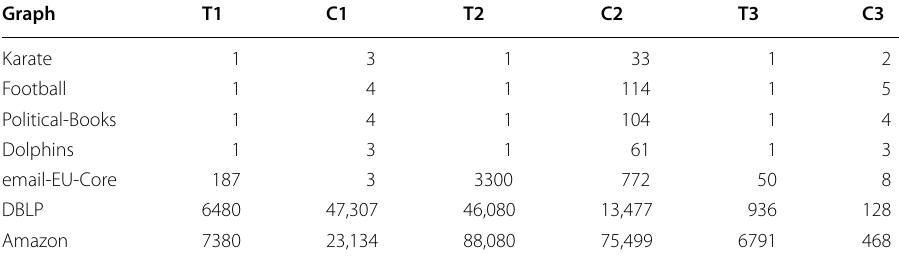
Table 6 Comparison with existing methods